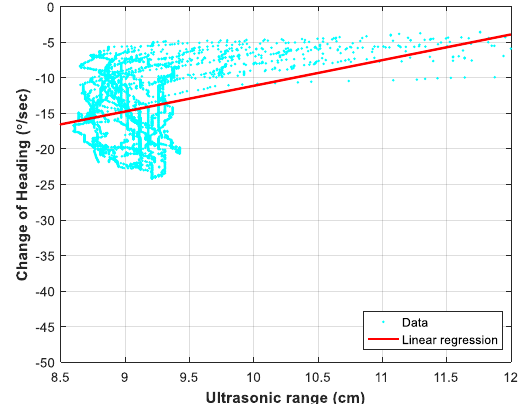
Figure 12. Ultrasonic range versus the estimated change of heading for the right turns category.